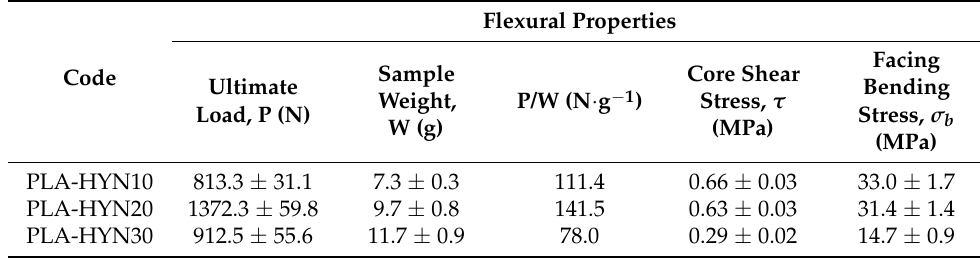
Figure 3. Pictures of the three-point bending test of composite sandwiches with PLA honeycomb cores with different thicknesses: The left column shows the initial elastic stage; the right column shows the image after the failure. Table 2. Flexural (three-point bending) properties of PLA-based sandwich structures with PLA honeycomb